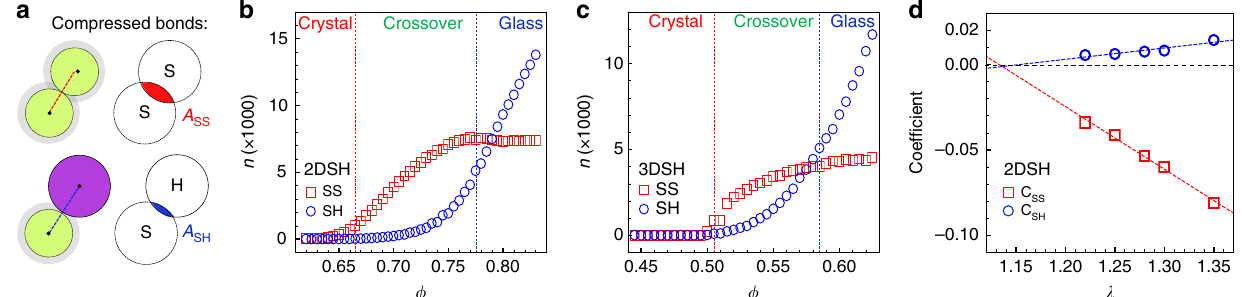
Fig. 5 The three regimes arise from the compression of soft – soft and soft – hard bonds. a The area change of compressing a soft – soft bond (red area A SS ) is greater than that of compressing a soft – hard bond (blue area A SH ). The compressed SS and SH bonds are de fi ned as pairs belonging to the fi rst and second subpeaks of the fi rst-layer neighbor separations, respectively, see Supplementary Fig. 5c. b , c The 2DSH system with ( η , λ ) = (0.5,1.3) and the 3DSH system with (0.4,1.25), respectively. The number of compressed SS bonds and SH bonds shows three regimes corresponding to the crystal, crossover and glass regimes. The vertical dashed lines denote the boundaries of the crossover regime measured from Fig. 2 for the 2DSH system and from Fig. 4c for the 3DSH system. The standard deviations are smaller than the symbol size and thus the error bars are not shown. d The coef fi cients of the SS and SH terms in Eq. 5 fi tted from Supplementary Fig. 7. Their linear extrapolations reach 0 (horizontal line) at λ ≃ 1.14, which coincides with λ = 1.16 when d = 2.0 in Fig. for the deviation from D in crossover regime, consistent with the result based on the RCP point in Fig. 3d.